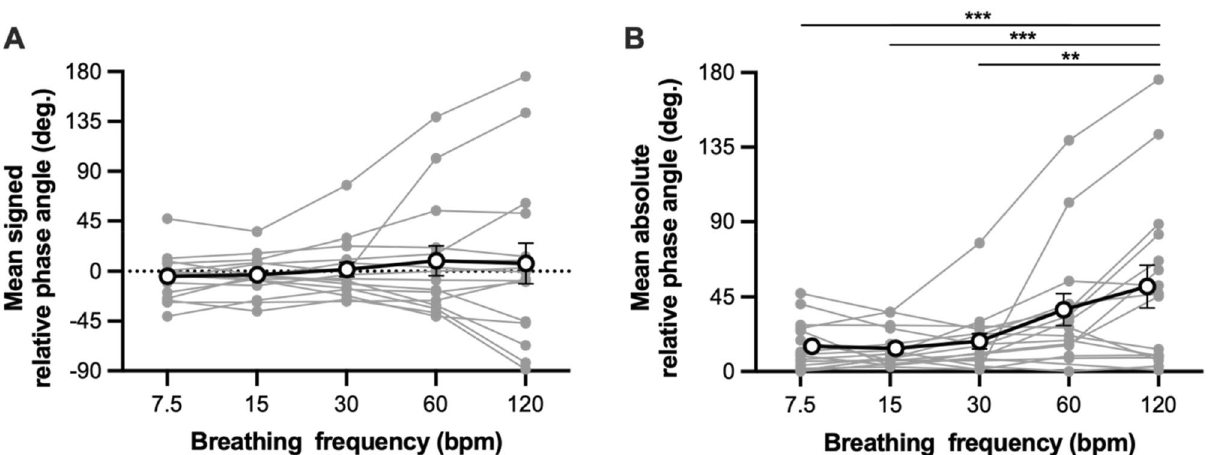
Figure 2. Mean signed and absolute relative phase angle between thoracic and abdominal movements. Solid markers represent individual participants. Open circles indicate mean value across participants. Vertical bars represent between-subject standard error. ** p < 0.01, *** p <